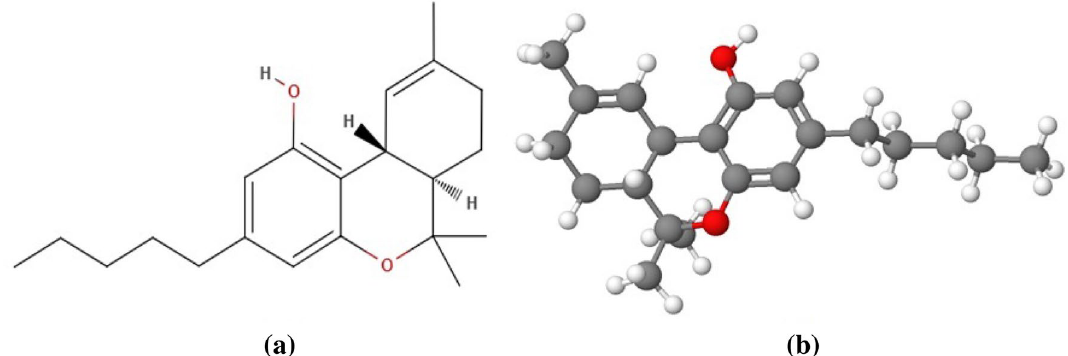
Fig. 1 Structural representation of Δ9-tetrahydrocannabinol a structural arrangement b 3D- model of the structure